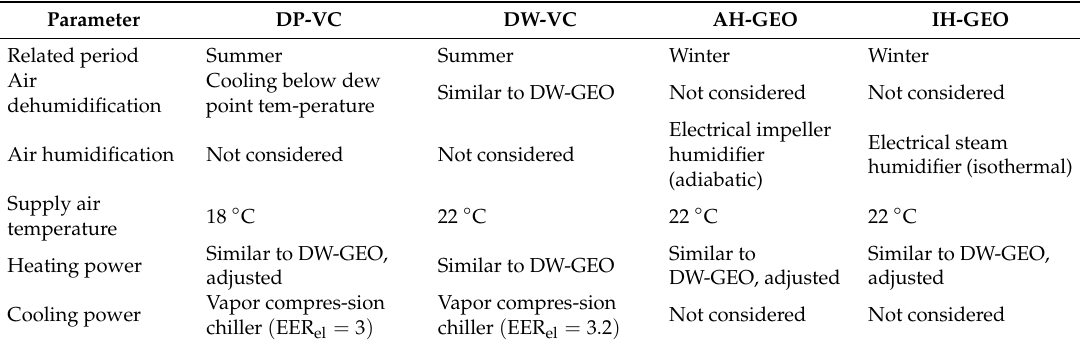
Table 4. Characteristics of reference